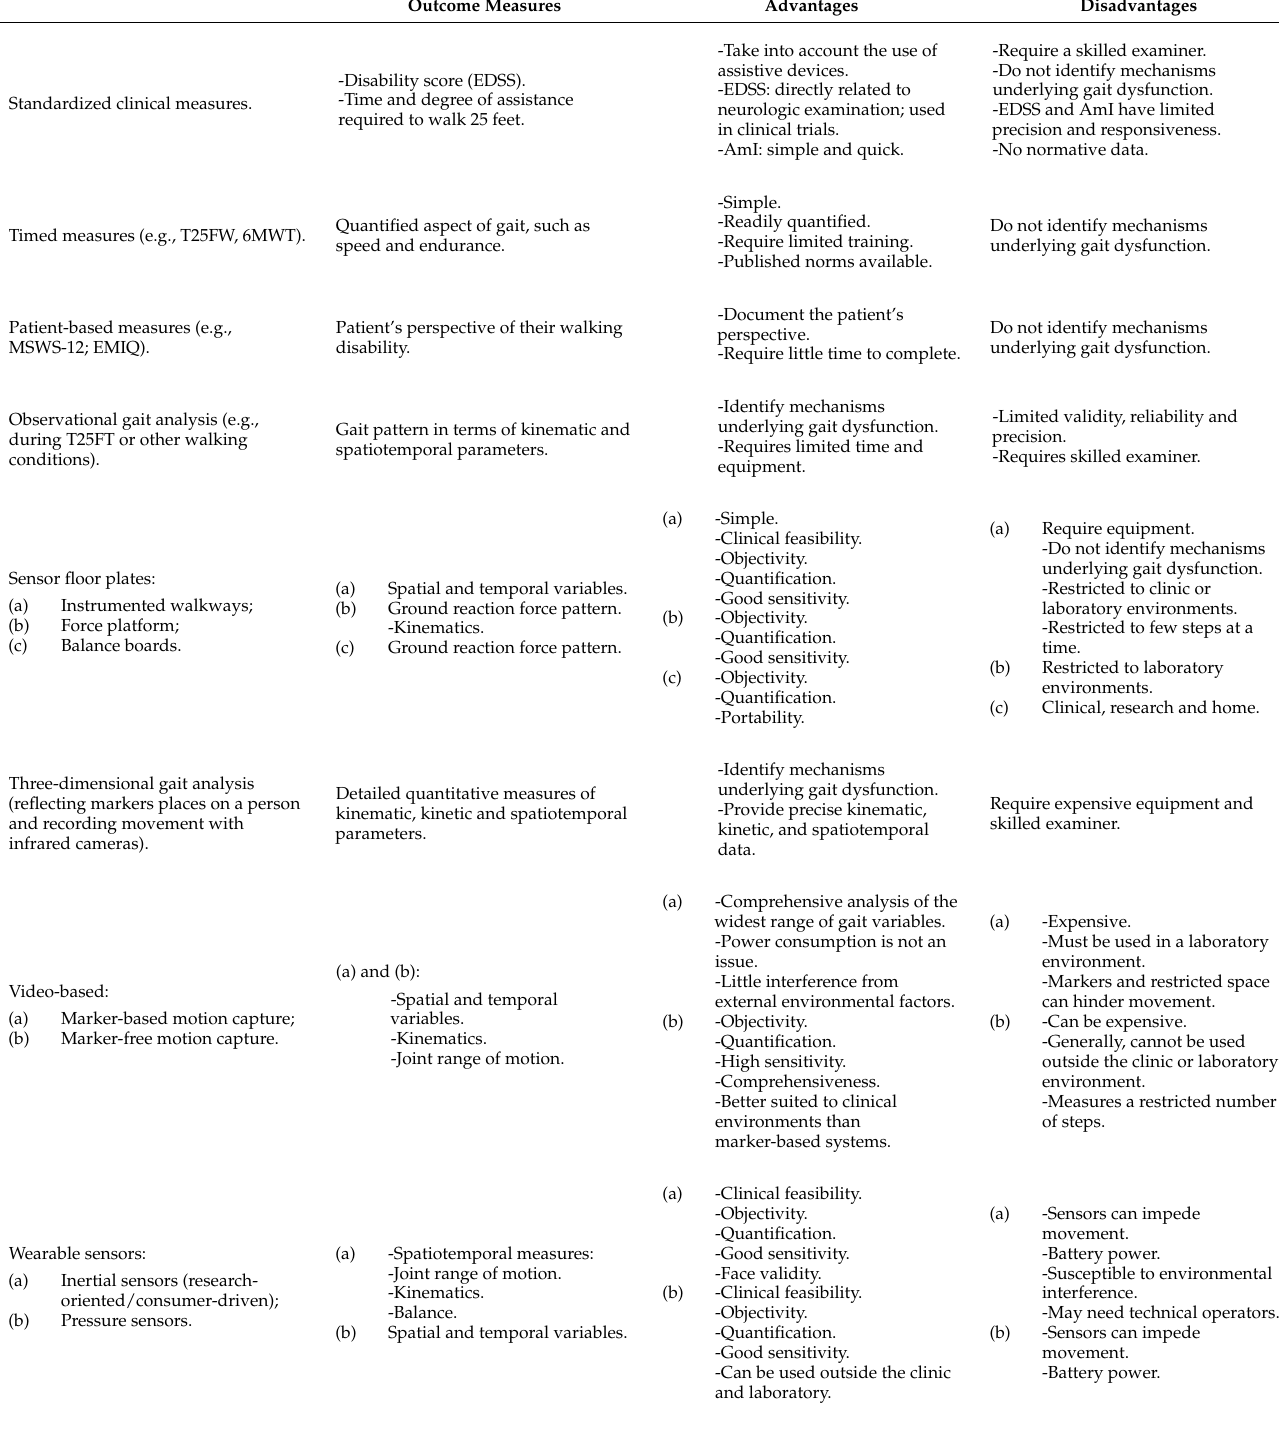
Table 2. Advantages and disadvantages of various gait assessment methods (AmI = ambulation index; EDSS = Expanded Disability Status Scale; T25FW = Timed 25-Foot Walk test; 6MWT = 6-Minute Walk Test; MSWS-12 = 12-item